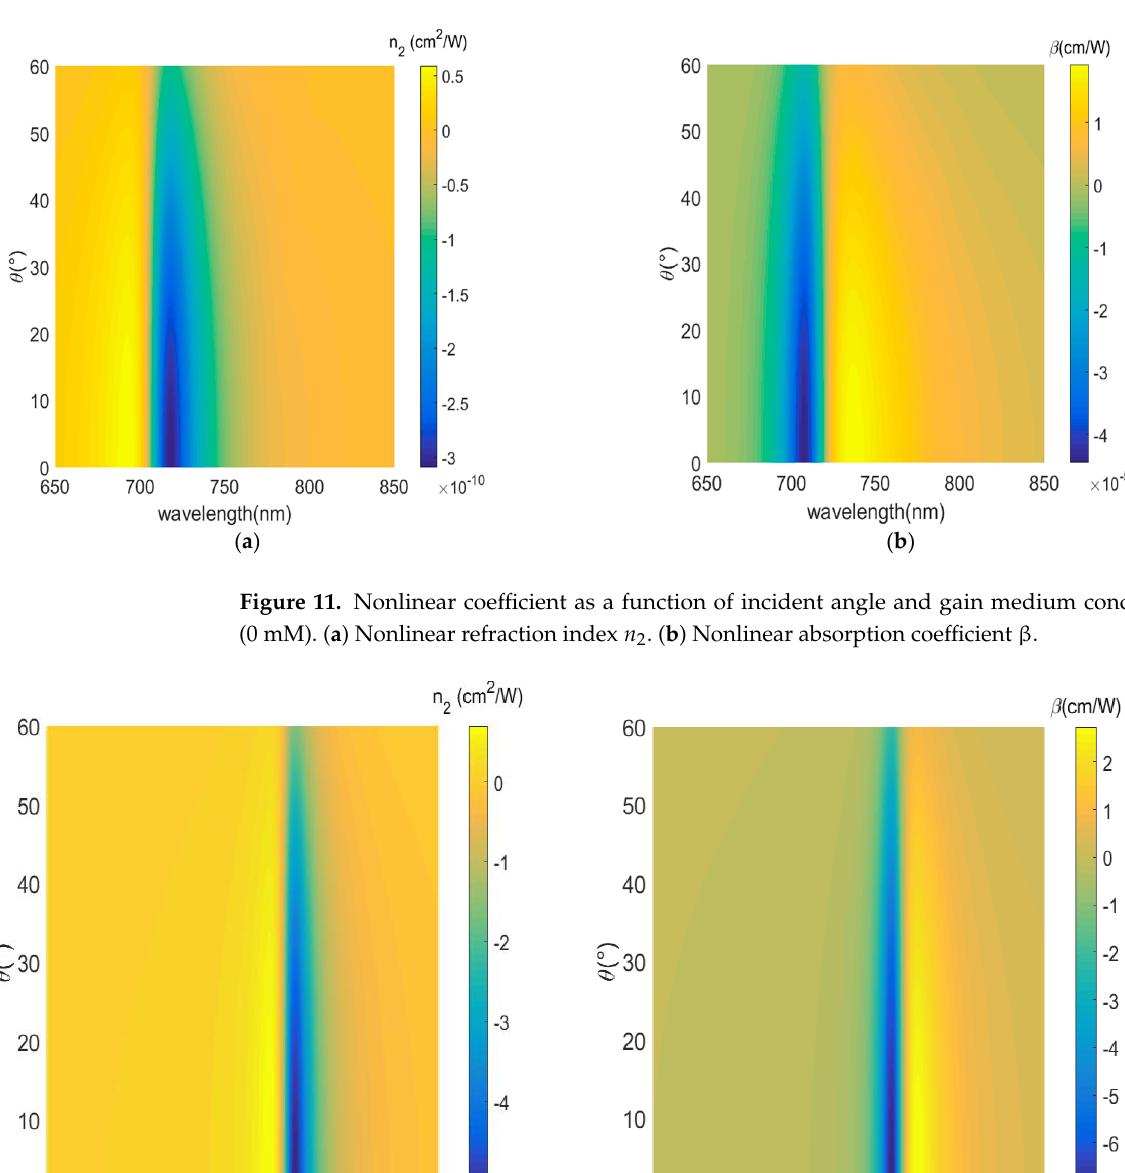
Table 2. Comparisons of the third-order nonlinear optical coefficients of different doping concentra-